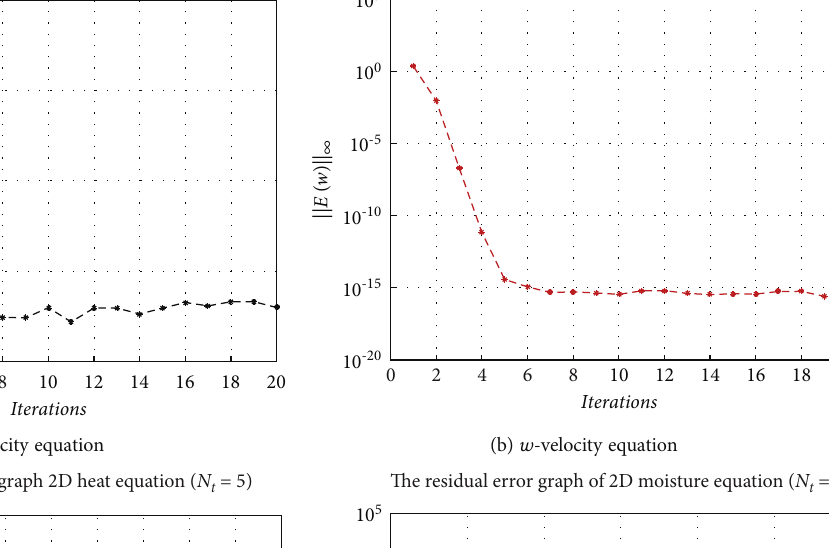
= N = 20 and N = 5 x z t